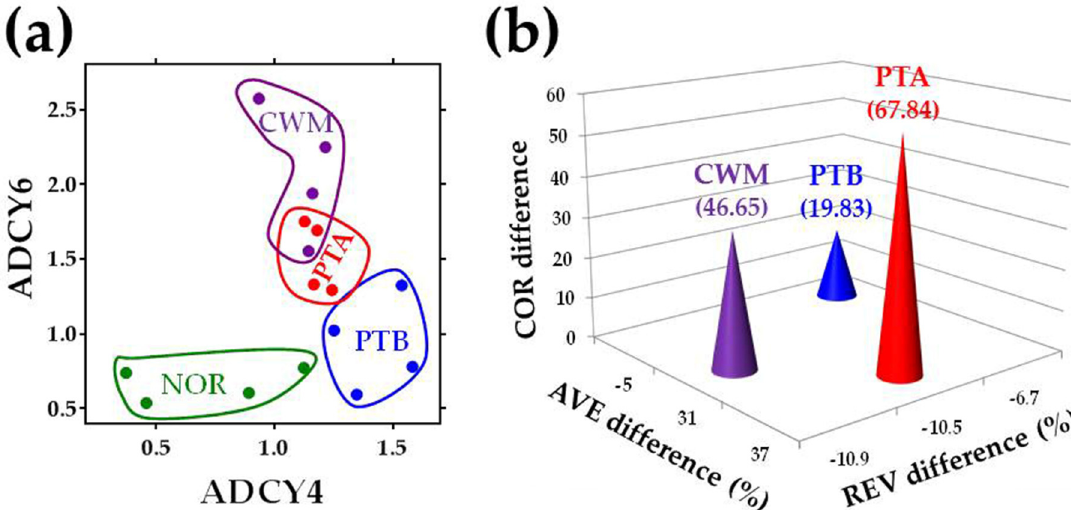
Figure 2. Separation of clear cell renal cell carcinoma (ccRCC) nodules in ( a ) two-gene expression level subspace; ( b ) 3D space of independent measures. ( a ) was limited to the adenylate cyclases 4 ( ADCY4 ) and 6 ( ADCY6 ), while ( b ) presents the normalized scores for all 130 chemokine signaling genes. Each colored bullet in ( a ) represents the expression levels of the two genes in one of the quarters of the indicated region. The tips of the cones in ( b ) point to the 3D coordinates of the alteration of the quantified genes from the chemokine signaling pathway in the three profiled cancer nodules. Note the clear separation of the three cancer transcriptomes and the shorter distance between PTA and chest wall metastasis (CWM).